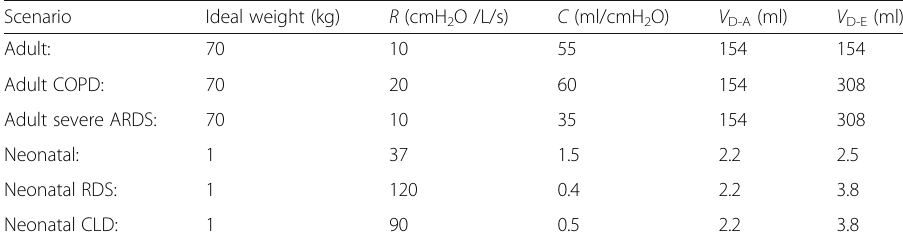
Table 2 Patient characteristics for different scenarios